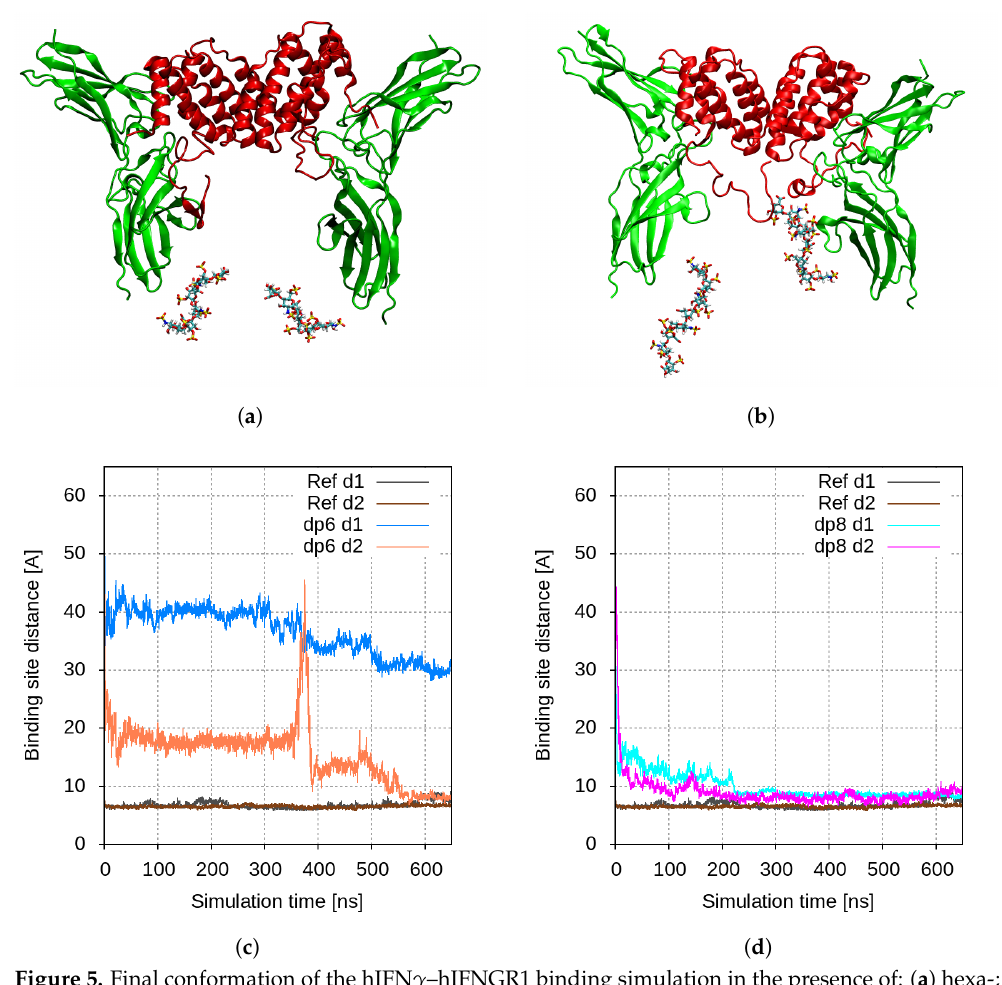
Figure 5. Final conformation of the hIFN γ –hIFNGR1 binding simulation in the presence of: ( a ) hexa-; or ( b ) octasaccharides. The cytokine and the receptor subunits are presented in red, resp. green cartoons, while the HS-derived oligosaccharides are colored by atom type and presented as licorice; time evolution of the COM distances d 1 and d 2 between the binding sites in the hIFN γ and hIFNGR1 molecules in the presence of: ( c ) hexa-; or ( d )